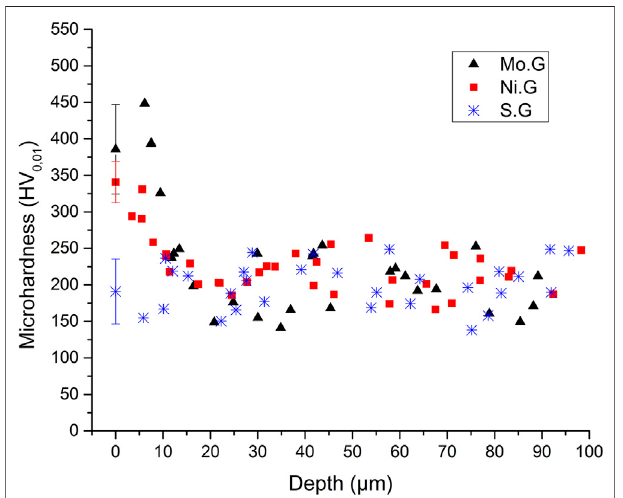
FIGURE 5 | Microhardness pro fi les (cross section) and the surface microhardness (0 µm) of the specimens.